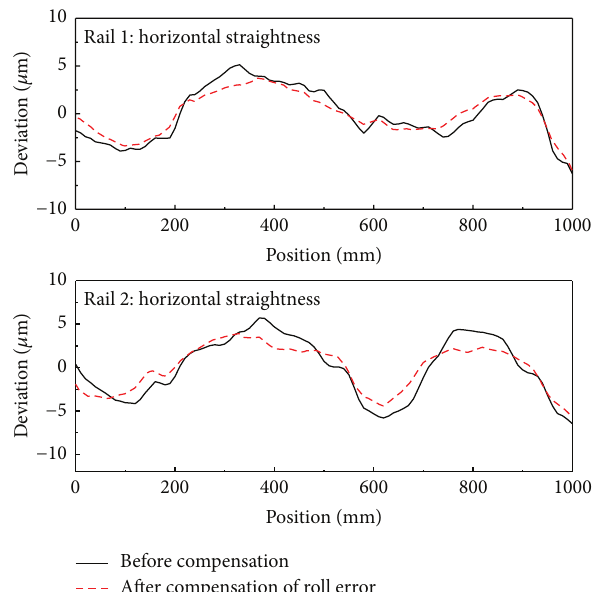
Figure 12: The horizontal component of the straightness error before and after compensating for roll error.